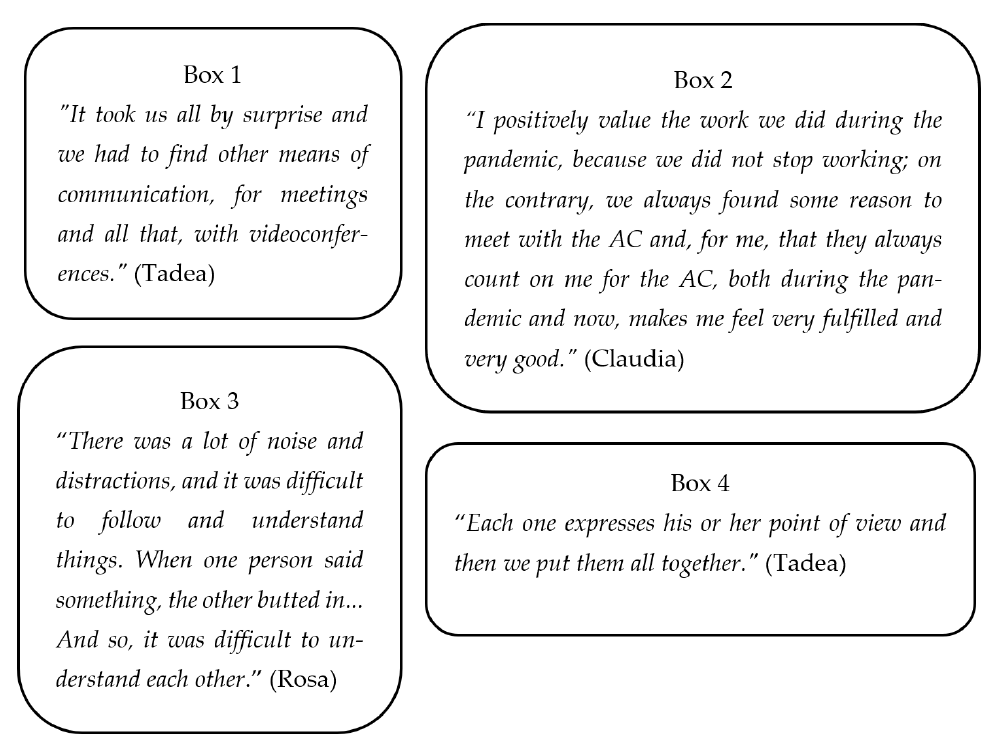
Figure 1. Co-researchers’ opinions 1–4.